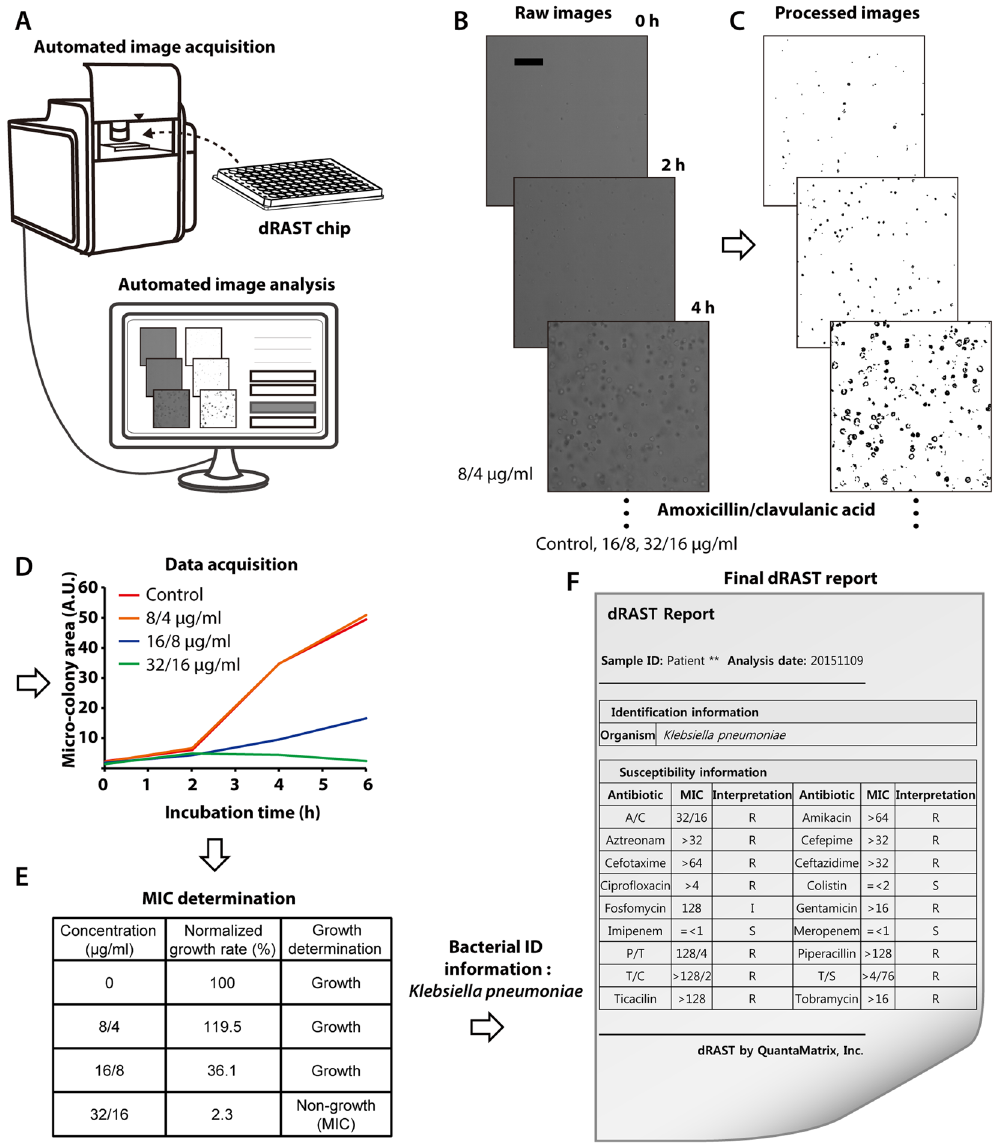
Figure 3. Automatic AST using colony-forming area detection. (A) Time-lapse images were acquired from the automated imaging system, and the image data were transferred to the analysis system. (B) Time-lapse images of K. pneumoniae with several concentrations of amoxicillin/clavulanic acid (A/C). (C) The raw images from (B) were processed to binary format images. The number of white pixels in the image represents the microcolony area. (D) Graph of the microcolony-forming area in (C) . From low A/C concentrations until 16/8 μ g/ml, there was a substantial increase in microcolony-forming area in the images. However, from 16/8 μ g/ ml to 32/16 μ g/ml, there was no substantial change in the area of bacteria. (E) The normalized growth rates at all the concentrations were calculated. Values higher than 20% were regarded as growth, and lower values were regarded as non-growth. From low A/C concentrations until 16/8 μ g/ml, the normalized growth rates were higher than 20% and regarded as growth. However, at 32/16 μ g/ml, the normalized growth rate was 2.3% and lower than 20%; thus, it was regarded as non-growth. Therefore, the MIC value was determined to be 32/16 μ g/ml. (F) Final AST report. Using the ID information and MIC interpretive criteria from CLSI, antibiotic susceptibility was determined in a full antimicrobial panel. The scale bars in (B) represent 100 μ